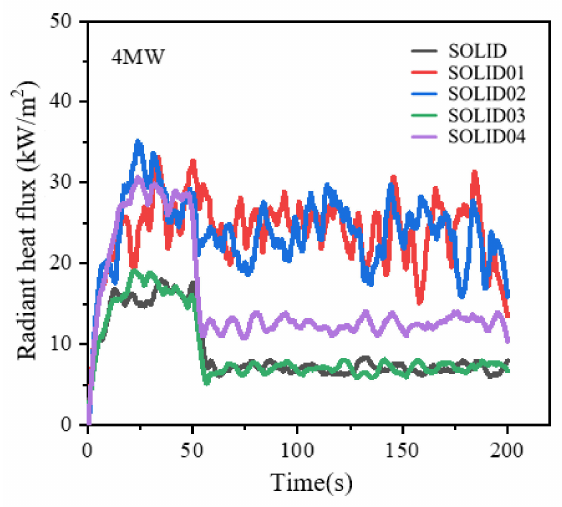
Figure 22. Glass radiant heat flux variation under window sprinkler